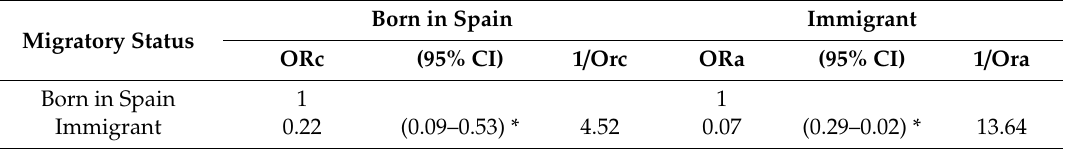
Table 3. Association (crude odds ratio (ORc) and adjusted odds ratio (ORa) with 95% confidence intervals (CI)) of common mental disorders of immigrants versus residents born in Spain.